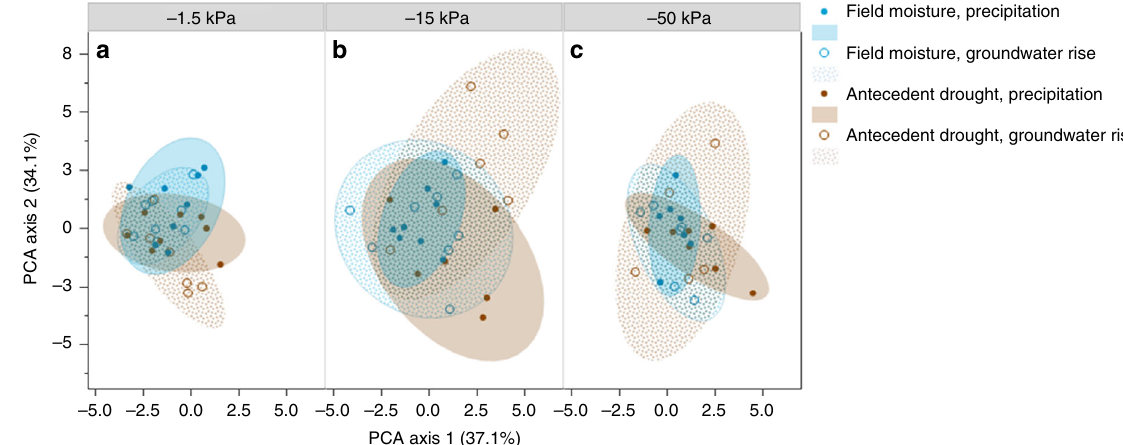
Fig. 1 Principal components analysis using the molecular composition of water-soluble organic carbon collected from different pore size suction domains. A principal components analysis (PCA) of Fourier-transform ion cyclotron resonance (FT-ICR) mass spectrometry de fi ned organic carbon compound classes (lipids, unsaturated hydrocarbons, lignin, proteins, and so on) for soil pore water collected at a − 1.5 kPa suction representing coarse-sized pores and pore-throats (approx. > 300 μ m diameter), b − 1.5 kPa suction representing medium-sized pores and pore-throats (approx. 20 – 300 μ m diameter), and c − 50 kPa suction representing fi ne pores and pore-throats (approx. 6 – 20 μ m diameter) collected from soil cores subjected to antecedent drought or maintained at fi eld moisture conditions and to different rewetting directions (rewet from the top to simulate precipitation wetting, or from below to simulate capillary-led groundwater rise) in the laboratory. Blue shaded points and solid-shaded 90% con fi dence interval ellipse represent pore water collected from soil cores subjected to fi eld moisture and precipitation-led rewetting conditions ( n = 8, 8, and 7 for − 1.5, − 15, and − 50 kPa pore water fractions, respectively), whereas open blue circles and pattern- fi lled con fi dence intervals represent fi eld moisture core rewet from below to